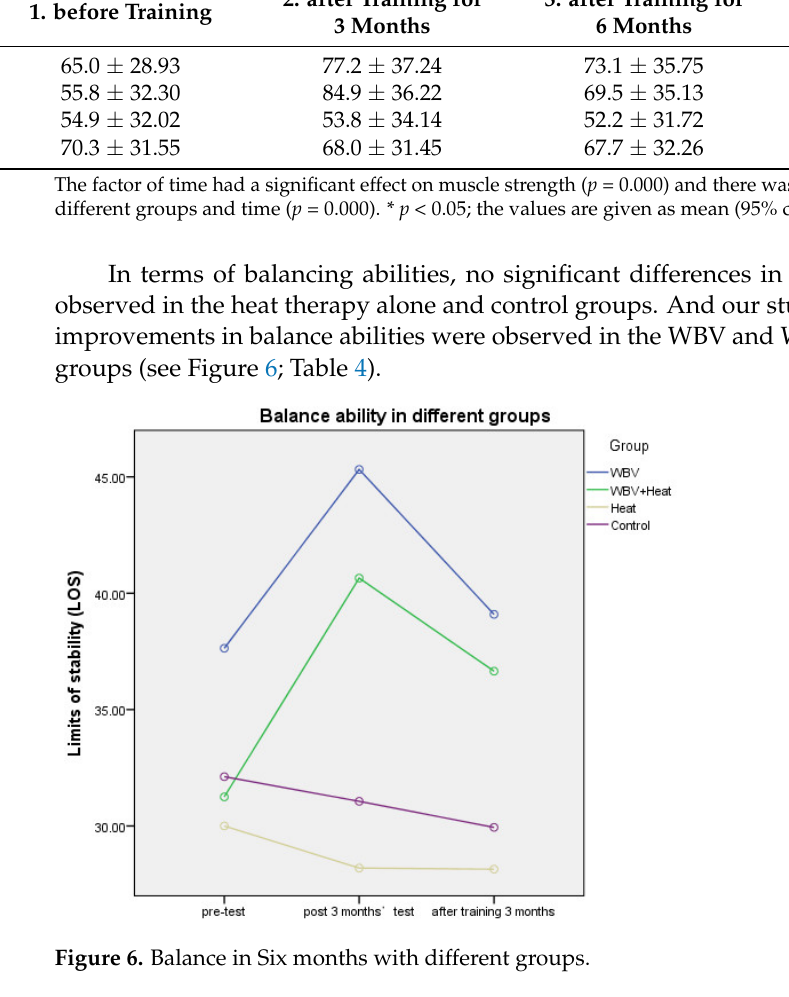
Figure 5. Muscle strength in six months with different groups. Table 3. Comparison of the Training Effect on Muscle Strength in Six Months.